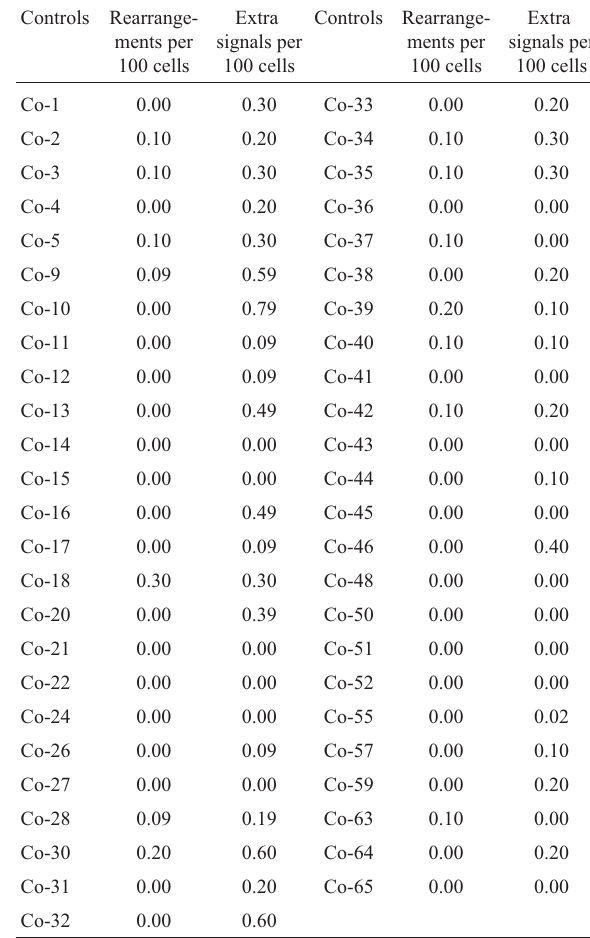
Table 2 - Frequencies of MLL rearrangements and extra signals in periph- eral blood lymphocytes from healthy individuals analyzed by